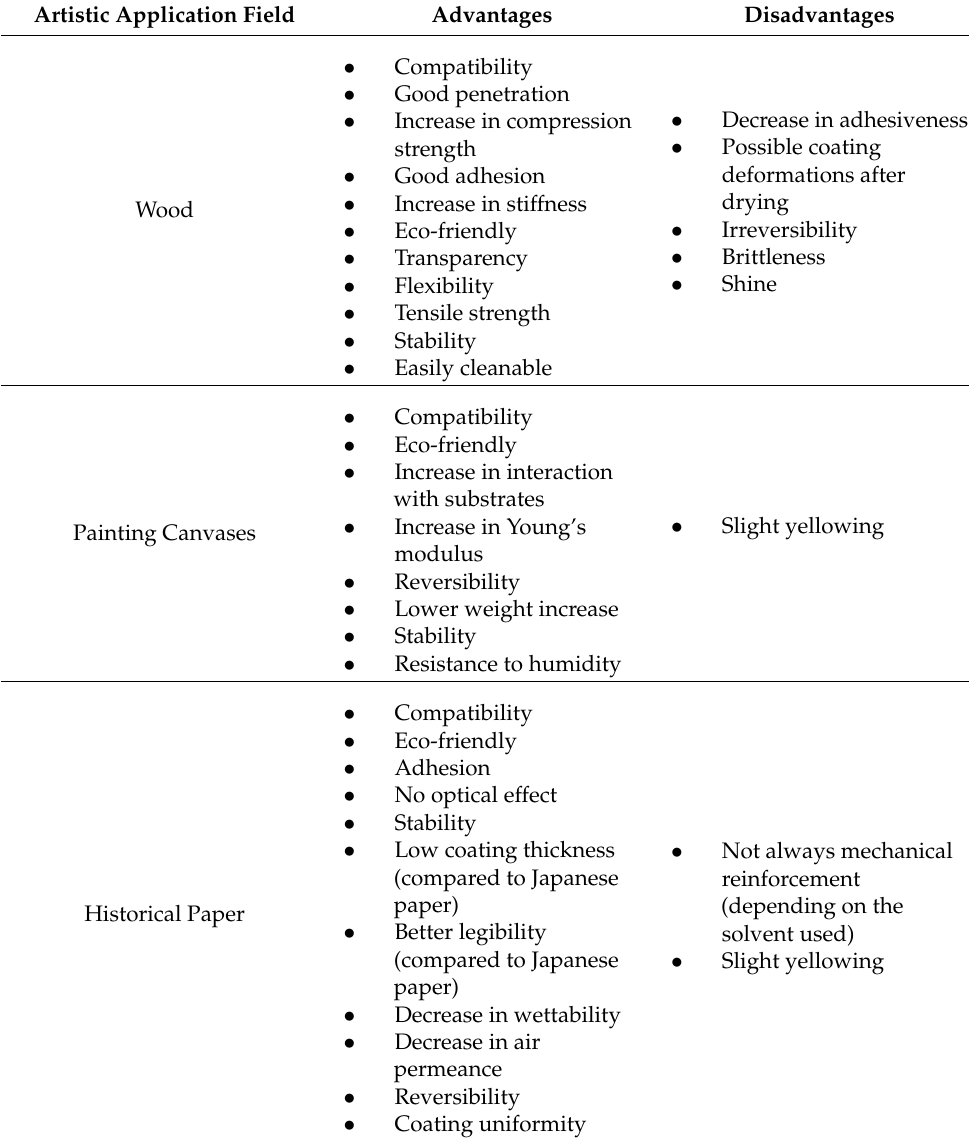
Table 4. Some advantages and disadvantages of nanocellulose applications for wood, paintings, and paper